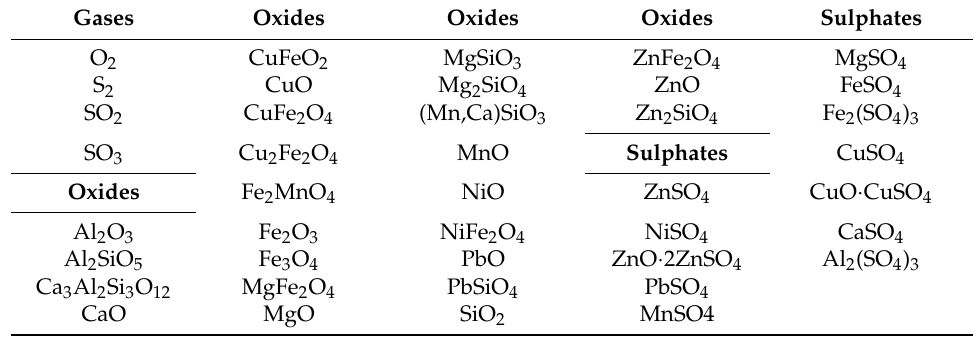
Table 1 . Phases (in bold) and species utilised in the thermodynamic model. Additionally, copper and nickel were inputted as Cu 2 S and NiS, respectively.